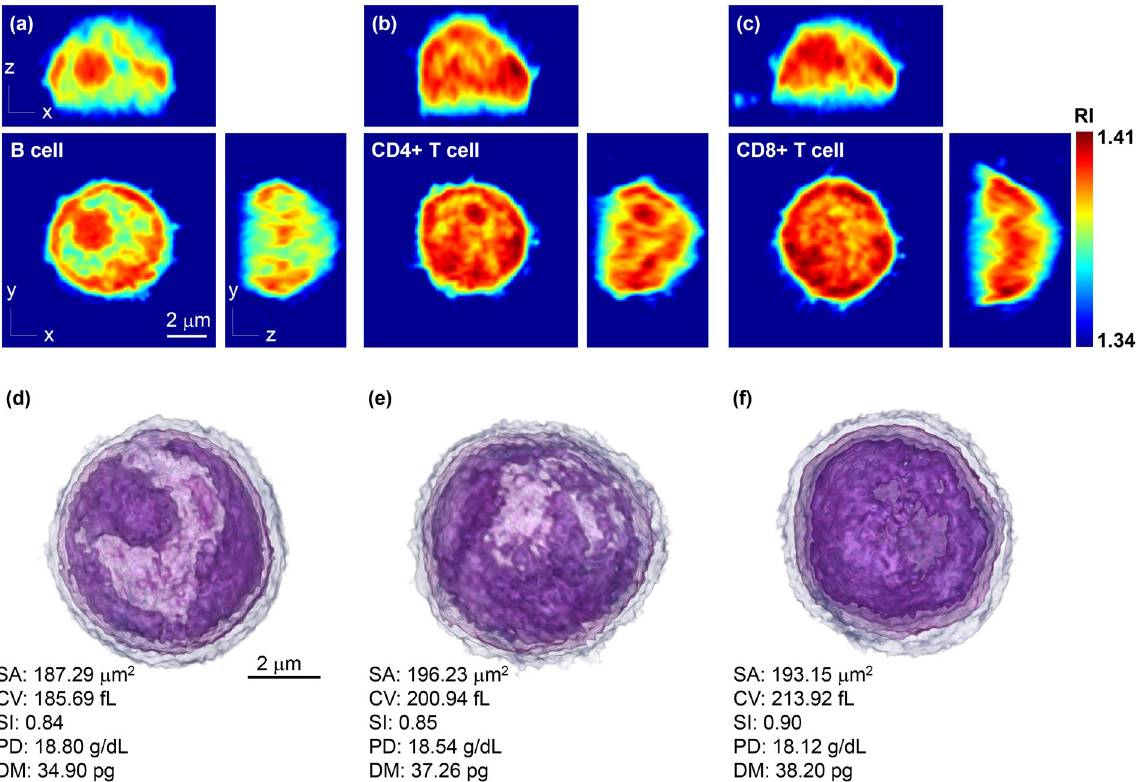
Figure 2. Representative 3-D RI tomograms of each lymphocyte cell type and the 3-D rendered images with quantitative characterization. Cross-sectional slices of a RI tomogram of ( a ) B cell, ( b ) CD4 + T cell, and ( c ) CD8 + T cell. Scale bar, 2 μ m. ( d – f ) 3-D rendered tomograms and quantitative characterization of the morphological and biochemical features of ( a – c ). Scale bar, 2 μ m. SA, surface area; CV, cellular volume; SI, sphericity; PD, protein density; DM, dry